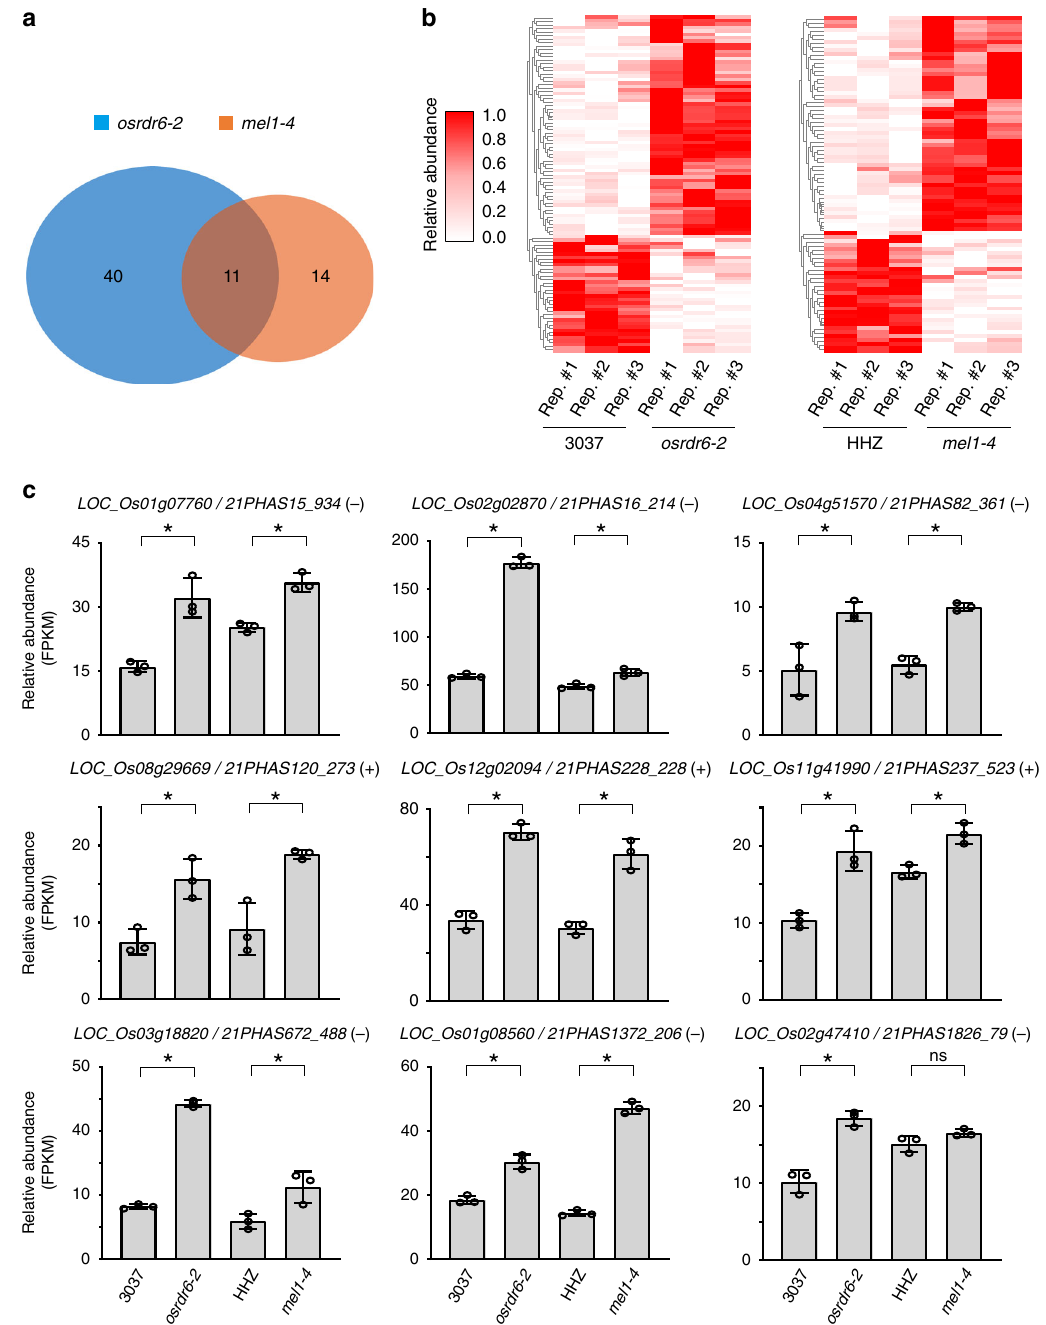
Fig. 4 21-nt phasiRNAs regulate target gene expression in early prophase I meiocytes. a Venn diagram showing the overlap of upregulated 21-nt phasiRNA targets in early prophase I meiocytes of osrdr6-2 and mel1-4 . b Heatmap showing the relative expression levels of upregulated and downregulated targets in early prophase I meiocytes of osrdr6-2 and mel1-4 and their respective wild-type plants. Colors represent the fractional density across the row of log2-transformed (FPKM + 1) values. c Relative expression levels of representative upregulated targets as determined by mRNA-seq. The error bars represent standard deviation of three biological replicates. Asterisks indicate signi fi cant differences between mutant and the corresponding wild- type plants. * q value ≤ 0.05. q values were calculated by Degradome sequencing . The degradome libraries (the regular PARE protocol) allowing no mismatches. 21-nt and 24-nt PHAS loci were identi fi ed and char- were constructed as previously described 32 . In brief, polyadenylated RNAs were acterized by PhaseTank and Unitas as previously described 48,49 using all 21-nt and 24-nt genome-matched reads from spikelets and male germ cells. PHAS loci puri fi ed from total RNA and those containing a 5 ′ monophosphate were ligated to identi fi ed by both of these two programs were considered as real PHAS loci. For an RNA adapter with a MmeI recognition site at its 3 ′ -end. After ligation, fi rst- examining the dependence of phasiRNA accumulation on MEL1 or OsRDR6, the read counts of each phasiRNA from three biological replicates of wild-type and mutant plants were compared using edgeR 50 . The resulting P value was adjusted to estimate false discovery rate (FDR). PhasiRNAs with a ≥ 2-fold reduction in the mutant and an FDR ≤ 0.05 were considered to be dependent on OsRDR6 or MEL1.